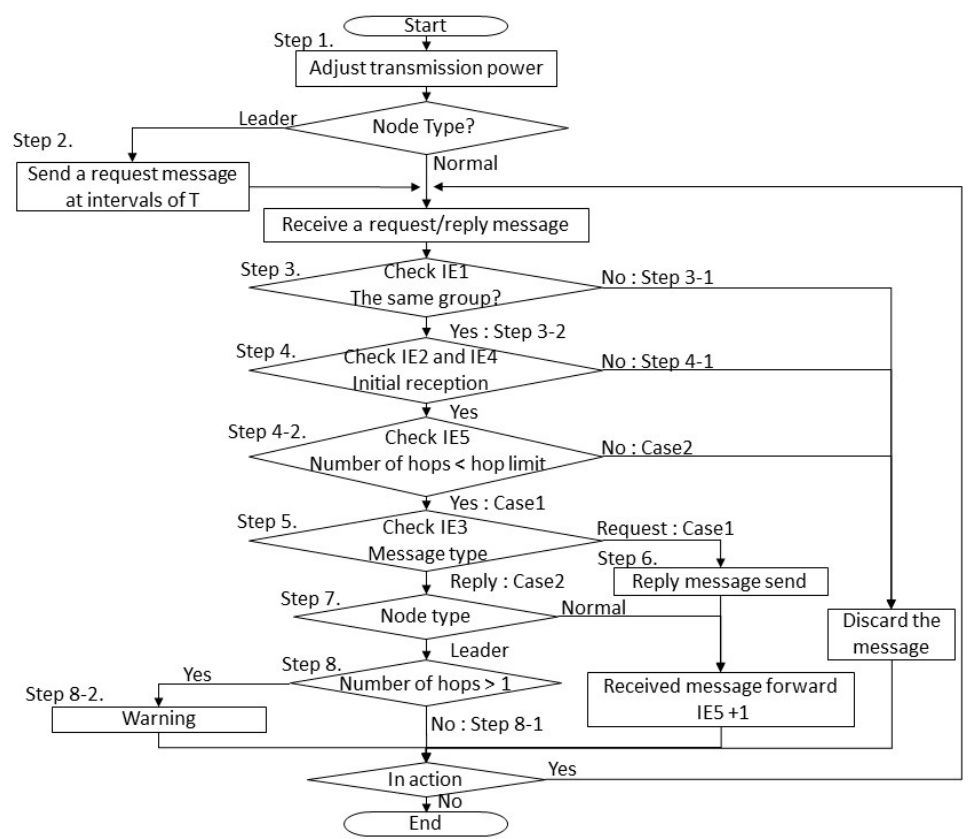
Figure 7. Flowchart for the request response-type stray node detection protocol.